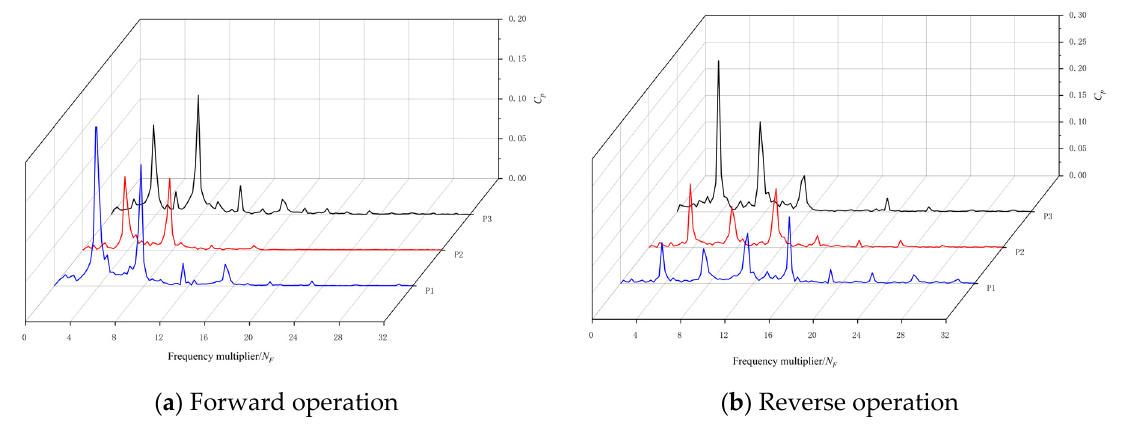
Figure 16. Pressure pulsation distribution of bidirectional axial flow pump in large flow rate of 1.20 Q bep .